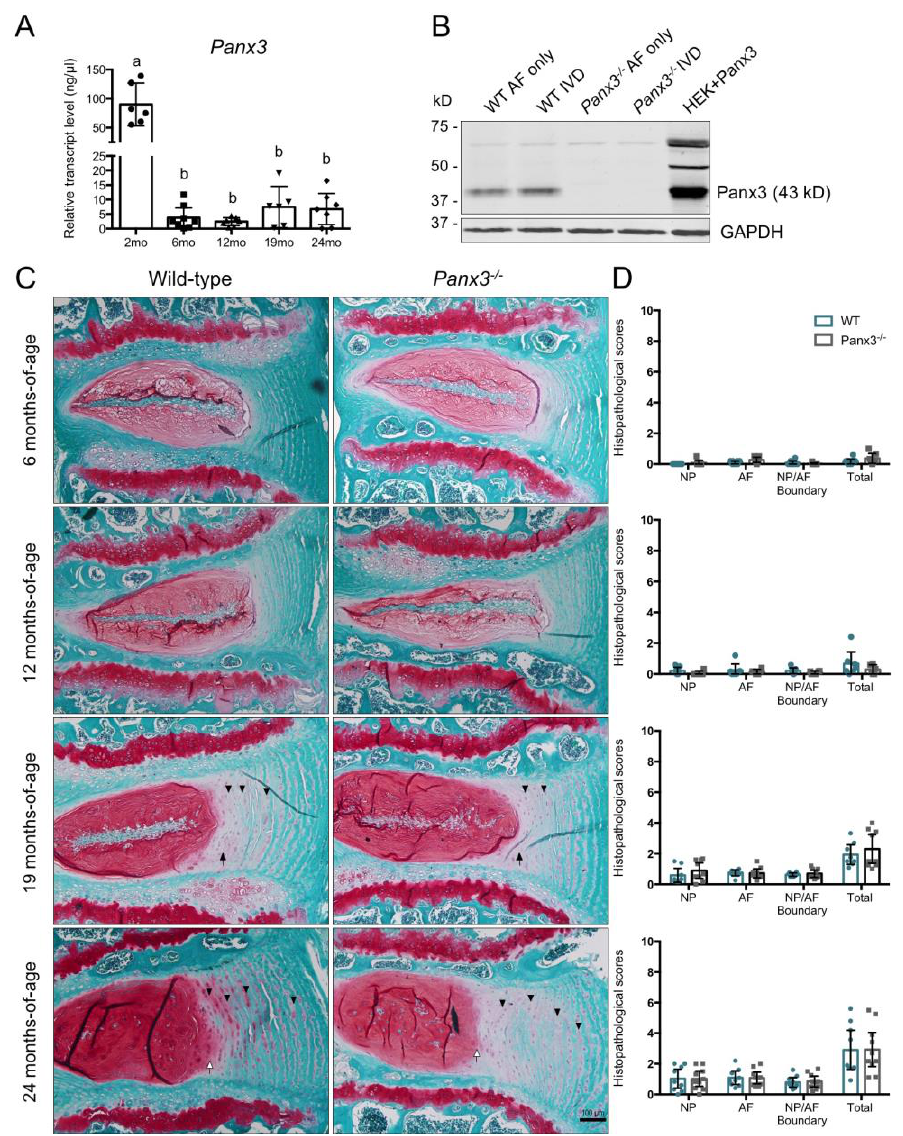
Figure 1. Loss of Panx3 does not alter age-associated intervertebral disc (IVD) degeneration. ( A ) Analysis of Panx3 gene expression in thoracic IVDs from wild-type (WT) mice at 2, 6, 12, 19 or 24 months-of-age. Transcript levels were determined relative to a six-point standard curve and data are presented as mean ± 95% CI. Values corresponding to each experimental animal are indicated by individual data points on bar graph. Bars labelled with the same letter are not significantly different based on p < 0.05; one-way ANOVA followed by Tukey’s post-hoc test (n = 6–8 mice per group, 6–8 IVDs pooled per mouse). ( B ) Western blot analysis of Panx3 protein in whole IVD or annulus fibrosus (AF) tissue from 2-month-old WT and Panx3 -/- mice. Panx3 overexpressing human embryonic kidney 293T cells (HEK + Panx3) served as positive control (expected size of Panx3 is 43kD). Images are representative of three biological replicates (8 IVDs from the lumbar and thoracic spine pooled per mouse). ( C ) Representative mid-sagittal sections of lumbar IVDs stained with safranin-O/fast green from 6, 12, 19 or 24-month-old WT and Panx3 -/- mice. Black arrows indicate disruption in lamellar organization at the NP-AF boundary, white arrows indicate loss of defined NP-AF boundary, arrowheads indicate increased glycosaminoglycan (GAG) staining in the inter-lamellar matrix. Images are representative of 6–10 mice per group, 4–6 IVDs per mouse. ( D ) Histopathological scores comparing WT and Panx3 -/- IVD tissues. Scores were assigned to the NP, AF and NP/AF boundary and summed for a total IVD score of 10. Higher scores represent a greater degree of degeneration. Data are presented as mean ± 95% CI (n = 6-10 mice per group, individual data points on bar graphs represent the average score of 4–6 IVDs per mouse).